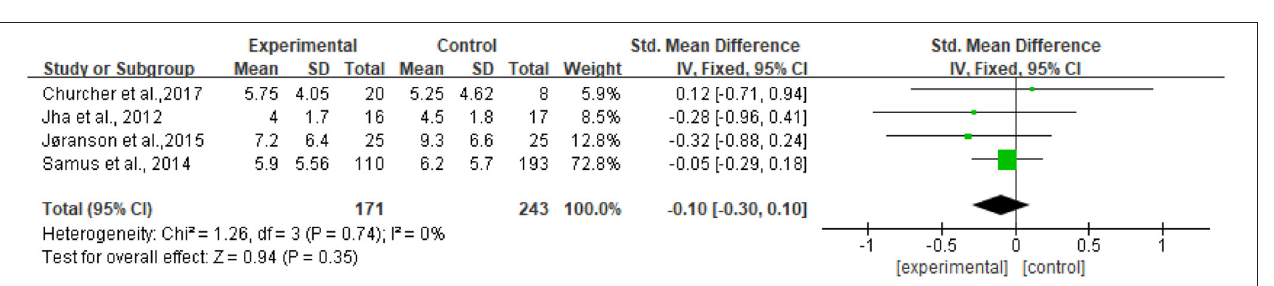
FIGURE 8 | Sensitivity analyses of the intervention group vs. the control group on CSDD rating